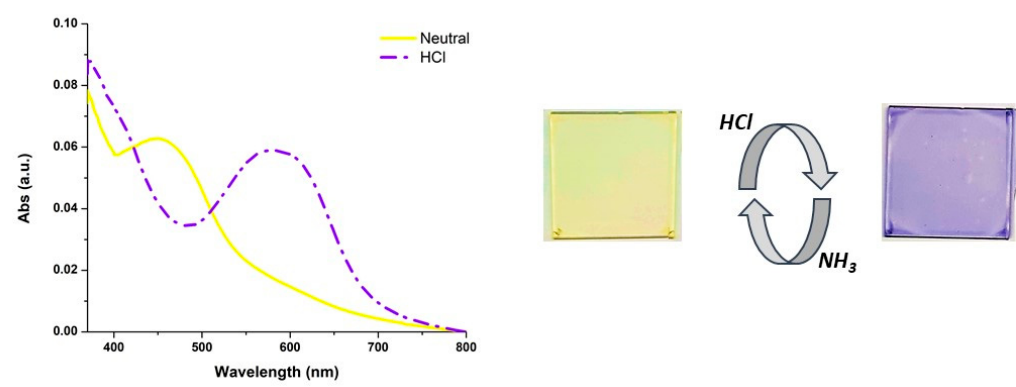
Figure 5. UV-vis spectra and digital pictures of glass slides coated with 1 (5 mM) before and after exposure to acidic vapors.